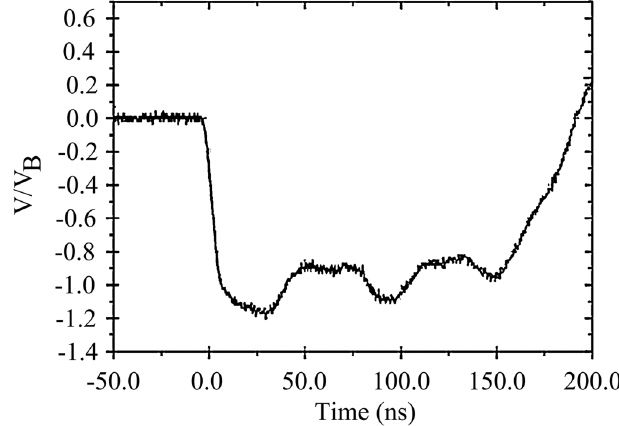
FIG. 5. Output voltage of the IEBA-A in the experiment, the parameters of the IEBA-A are Z 1 ¼ 6 : 2 (cid:6) , Z 3 ¼ 6 : 2 (cid:6) , Z 2 ¼ ¼ 10 (cid:6) , (cid:1) ¼ 70 ns , (cid:1) ¼ 10 ns 9 (cid:6) , Z L 1 2